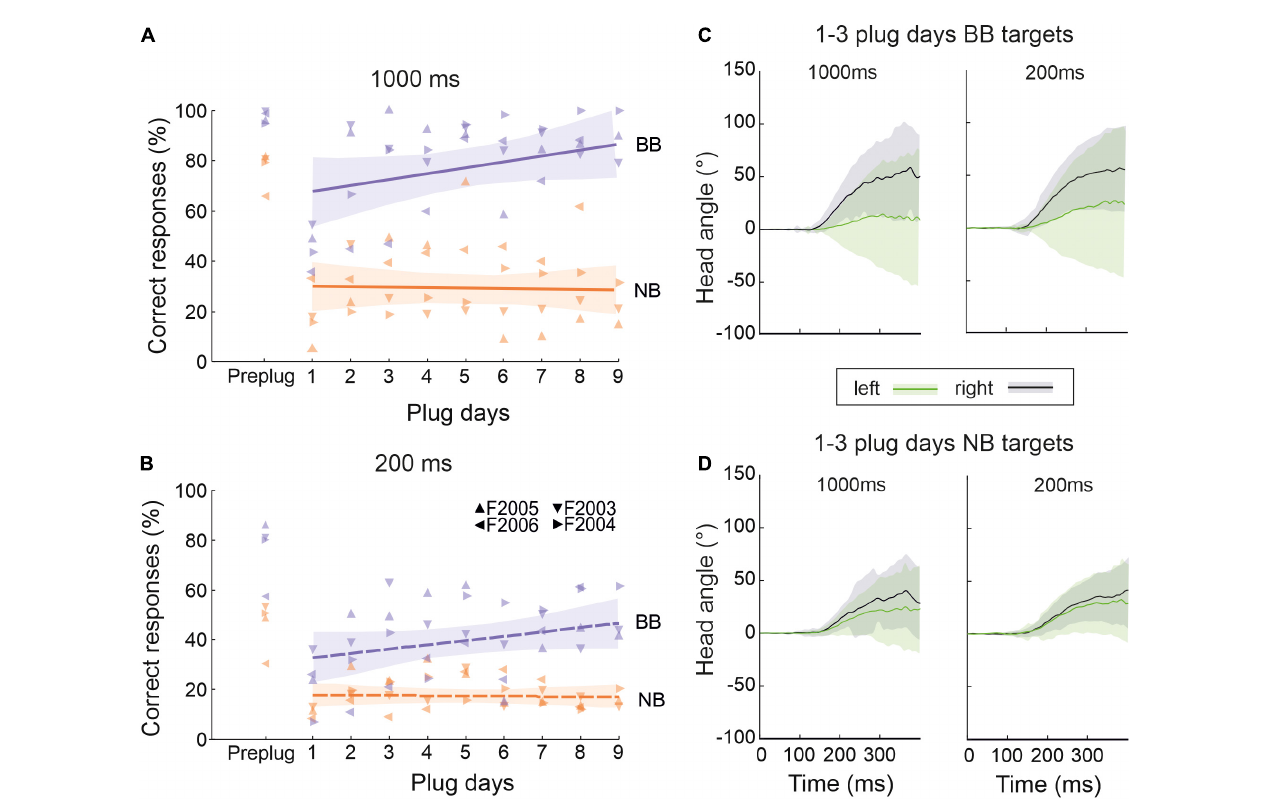
FIGURE8 Role of dynamic and spectral cues in adaptation to unilateral conductive hearing loss. (A) Percentage of correct responses for 1,000-ms broadband noise (purple, BB) and 1/6 octave narrowband noise bursts with a center frequency of 15 kHz (orange, NB) over the course of daily training with one ear occluded. Colored lines are linear regressions, and the shaded areas correspond to the 95% confidence intervals. The symbols represent individual animals. (B) Same as panel (A) but for stimuli with a duration of 200 ms. (C) Change in the mean ( ± S.E.) horizontal angle of the head over time following BB target onset at time 0 ms. These measurements were taken at the start (days 1–3) of the ear-plugging run, combined across target locations in the left (green) and right (black) hemifields, and are plotted separately for 1000-ms (left) and 200-ms (right) noise bursts. (D) Same as panel (C) but for NB target